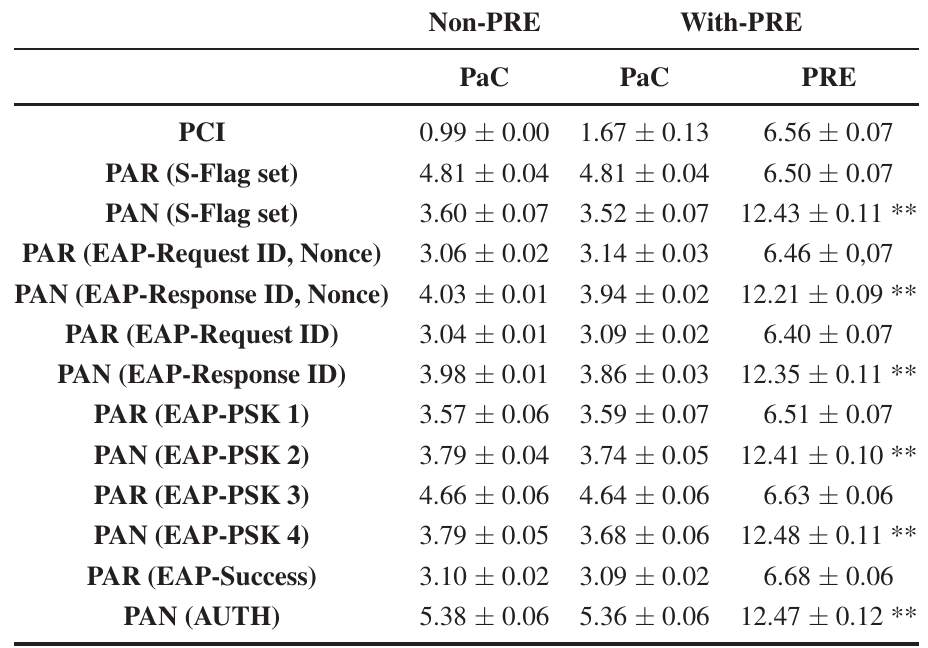
Table 3. Authentication messages. Mean processing time (ticks).